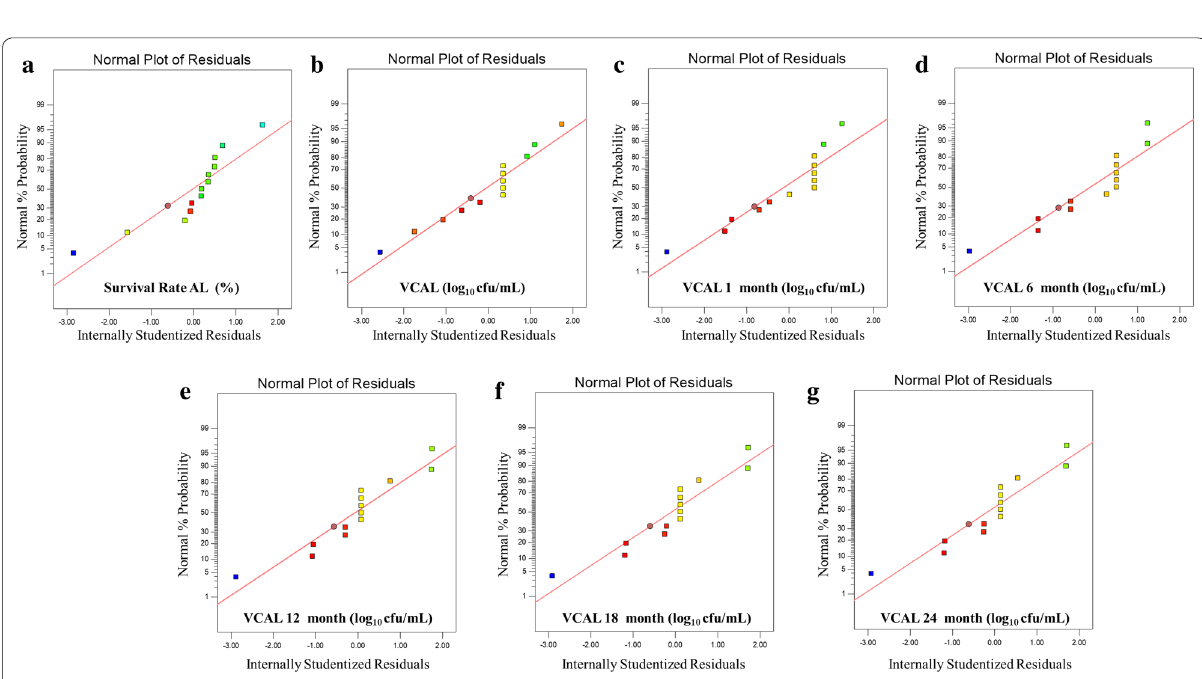
Fig. 4 Normal plot of residuals for responses a survival rate (%), log 10 CFU/mL values obtained in b viable count after lyophilization [VCAL], c VCAL 1 month, d VCAL 6 months, e VCAL 12 months, f VCAL 18 months and g VCAL 24 months lyophilized probiotics